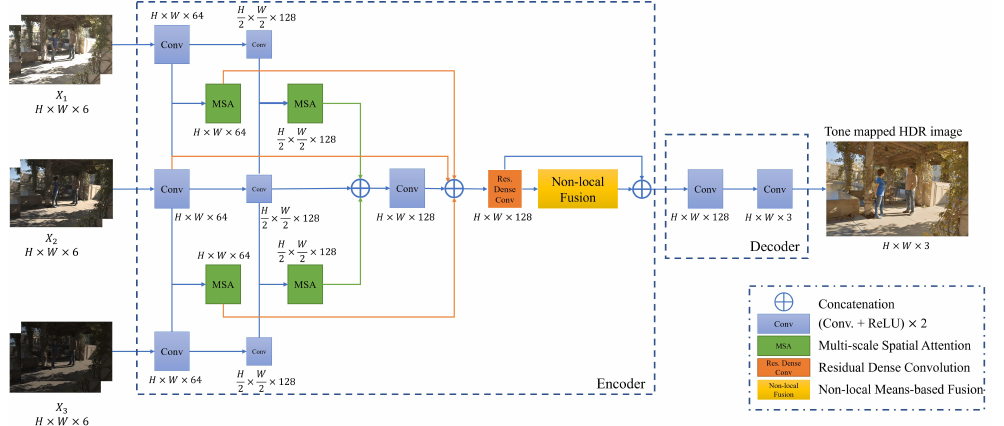
Figure 2. Overview of the proposed MSANLnet for HDR image